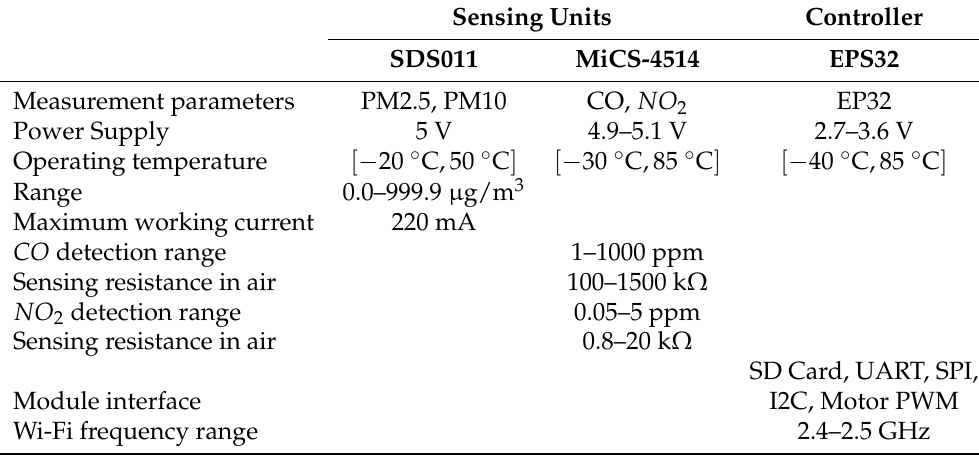
Table 1. Main characteristics of the sensing units (SDS011 and MiCS-4514) and controller